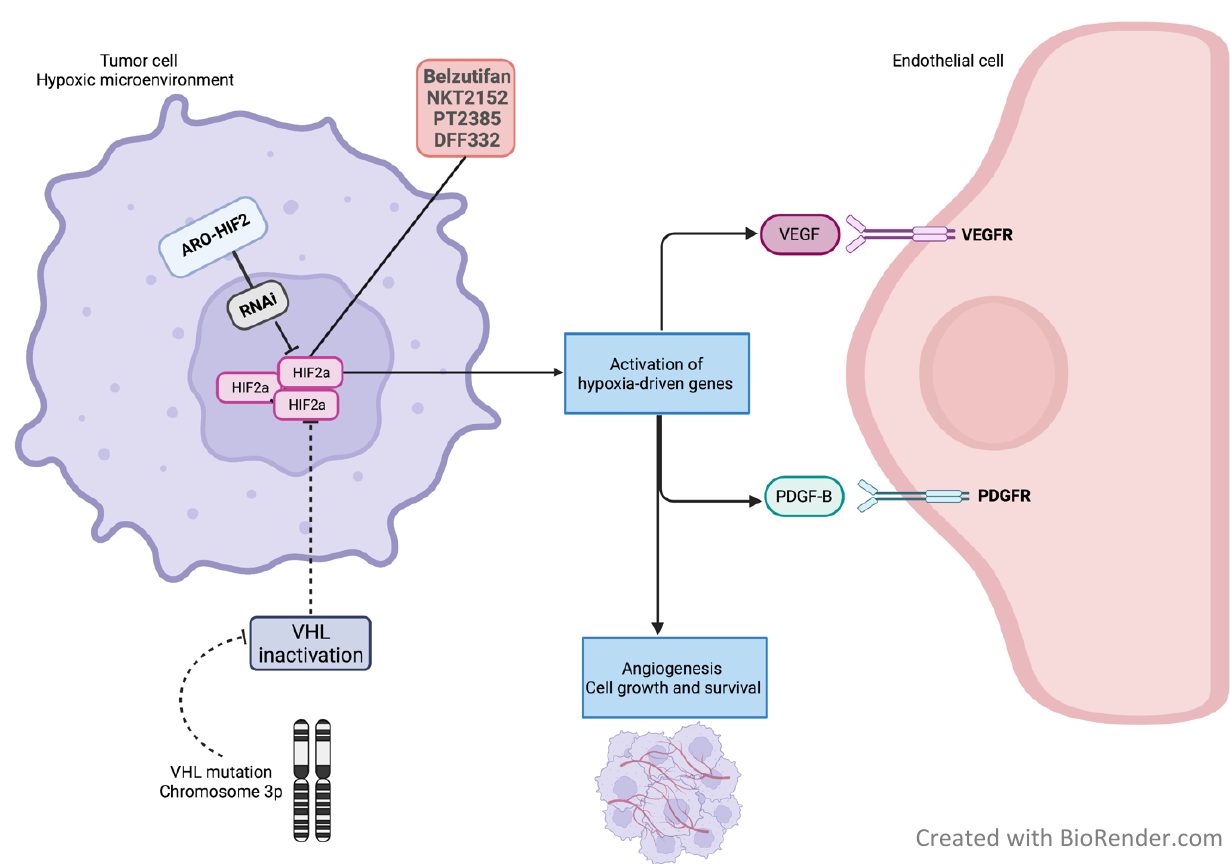
Figure 1. Mechanism of action of HIF2α inhibitors in RCC.